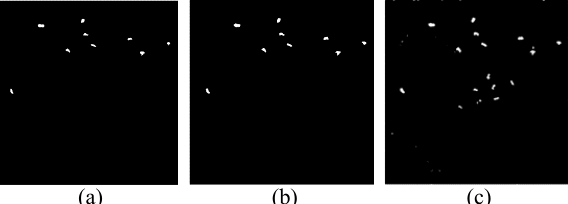
Figure 21. Change images which the backscatter enhanced and weakened regions are both classified as the changed regions on Beijing data set. (a) KSW-GA. (b) D-OTSU. (c) RTC.